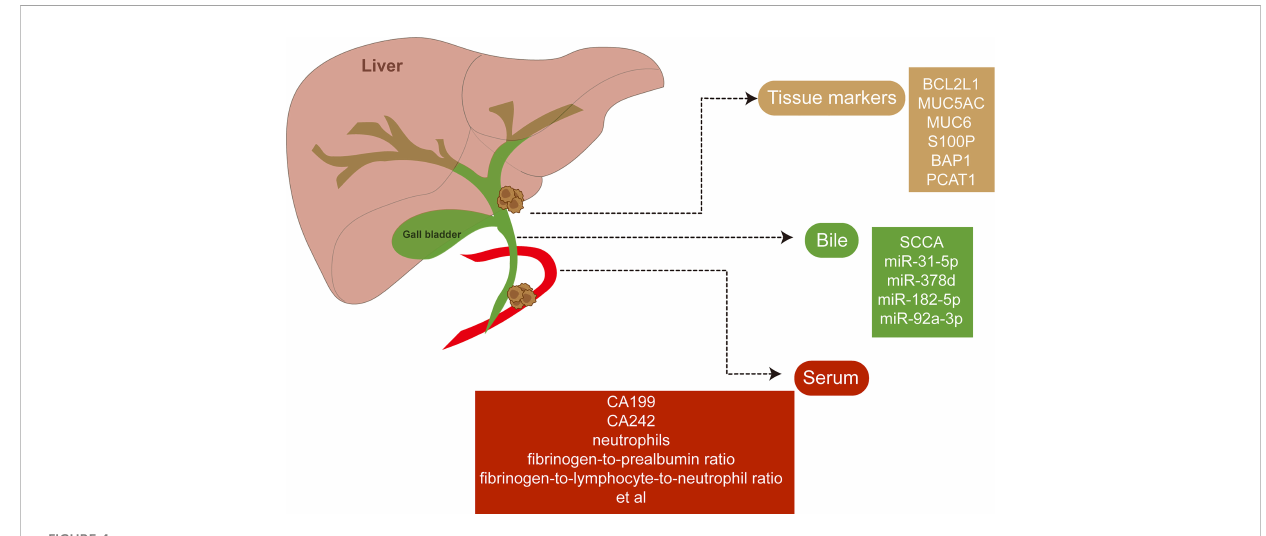
FIGURE 4 Potential biomarkers of extrahepatic cholangiocarcinoma. Novel biomarkers of extrahepatic cholangiocarcinoma have been discovered with abundant specimens including tissues, bile, and serum available.